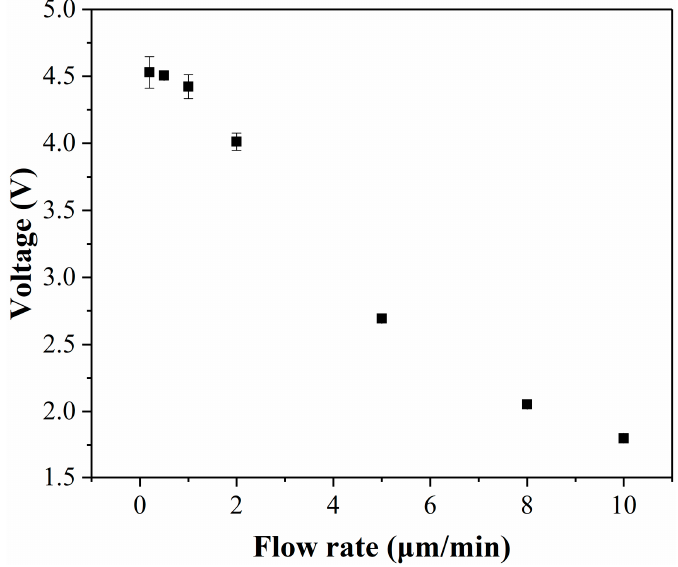
Figure 4. E ff ect of fl ow rate on detection results. Figure 4. Effect of flow rate on detection